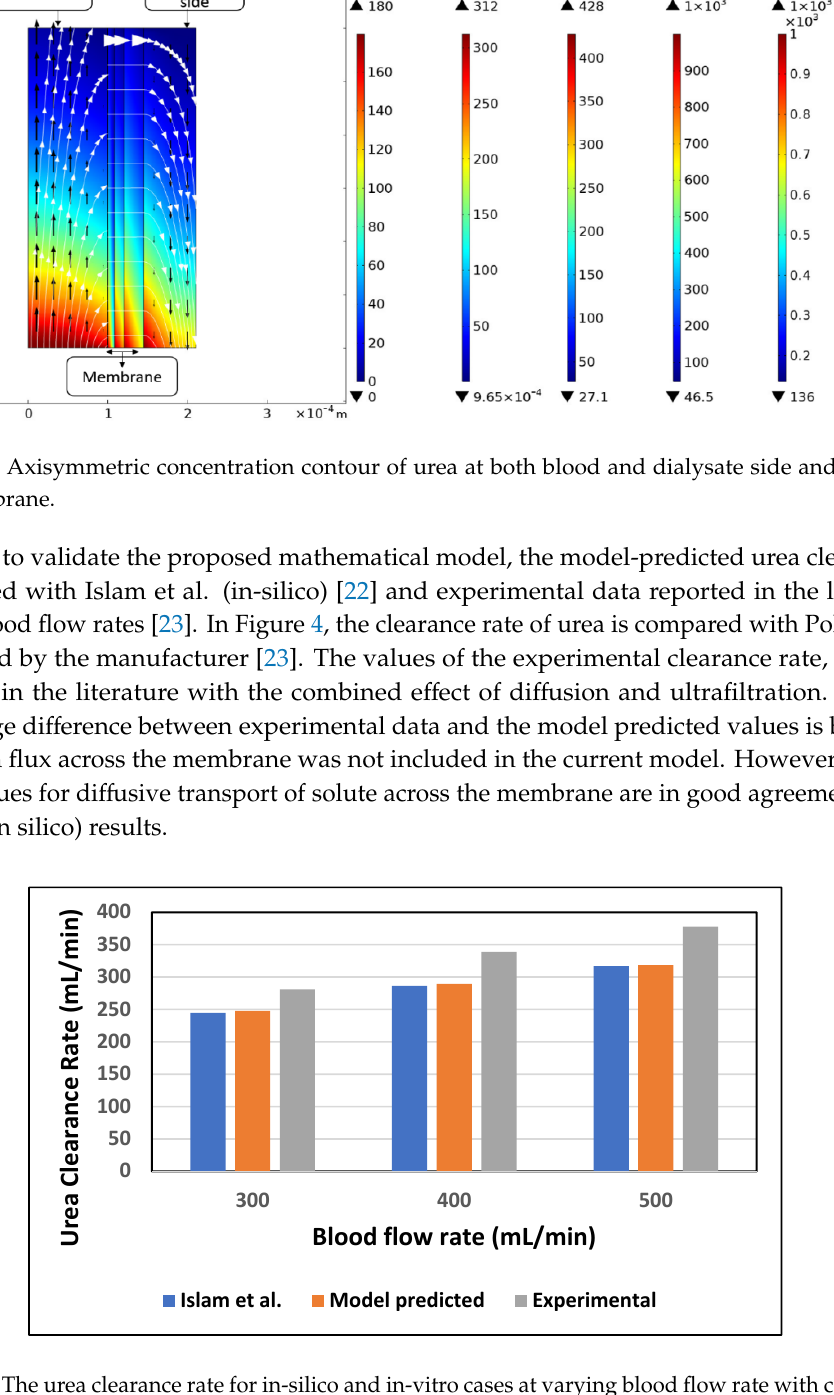
Figure 4. The urea clearance rate for in-silico and in-vitro cases at varying blood flow rate with constant dialysate flow rate (Q D = 500 mL/min).